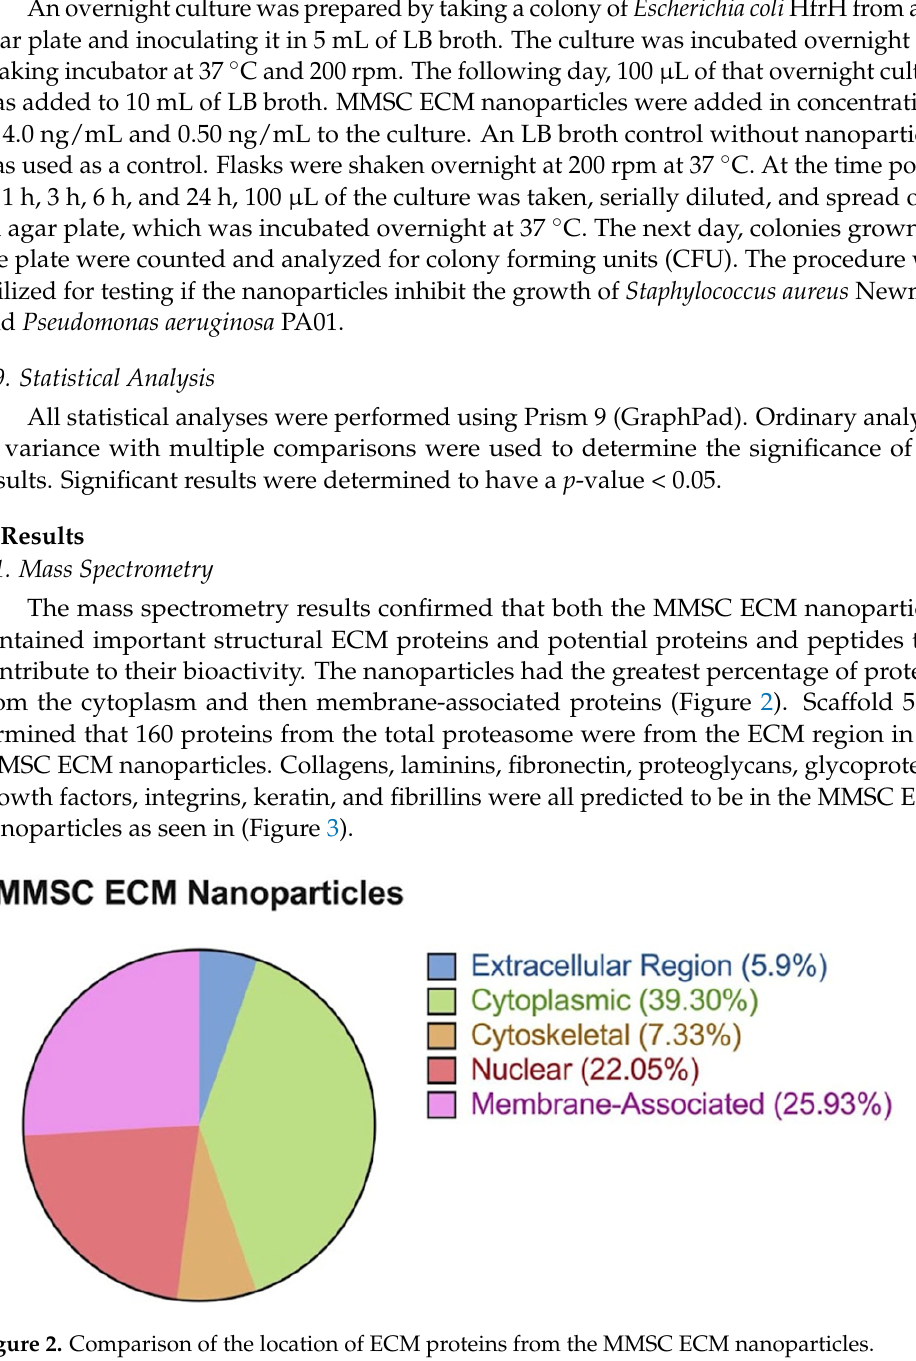
Figure 3. Categorization of ECM proteins found in the MMSC ECM nanoparticles. Table 1. Selected MMSC ECM nanoparticle proteins and their predicted bioactivity ranking from PeptideRanker. Peptides are listed from the highest bioactivity score to the lowest. ECM Protein